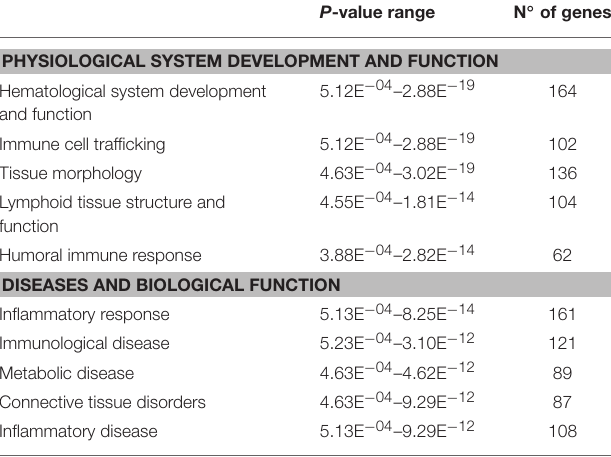
TABLE 3 | Biological functions, physiological processes, and diseases that were over-represented by genes that were differentially regulated due to the high-fat diet. P -value range N ◦ of